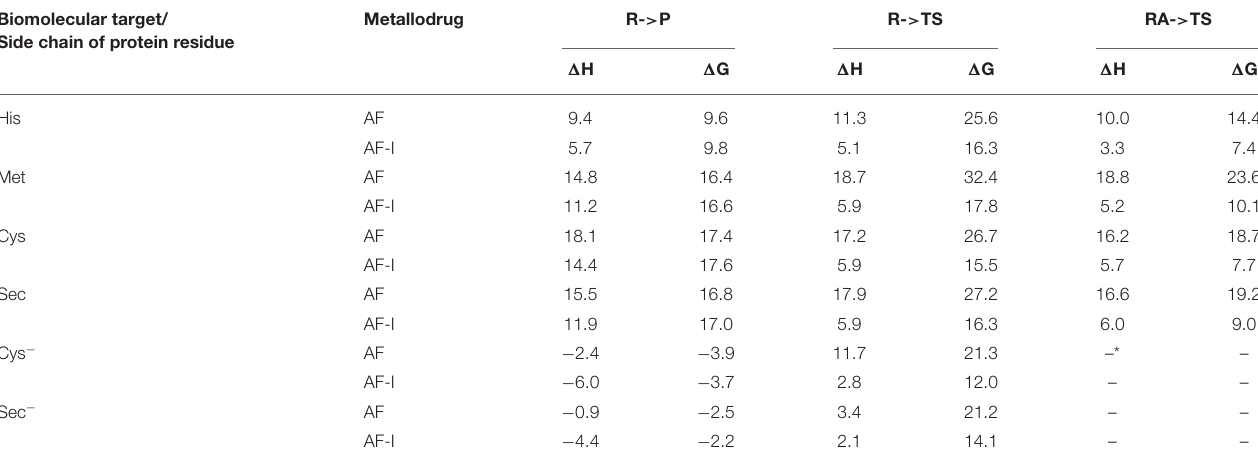
TABLE 3 | Enthalpies and Gibbs free energies for reaction of AF/AF-I with various biomolecular targets in solution. Biomolecular target/ Side chain of protein residue